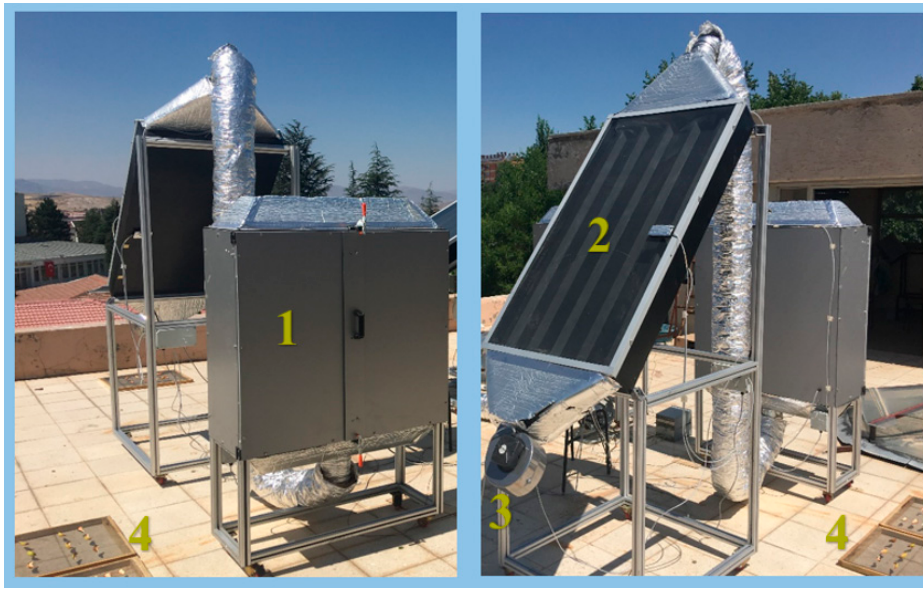
Figure 1. Experimental set-up: (1) drying cabinet; (2) solar collector; (3) circulation fan; (4) pear drying under the sun.